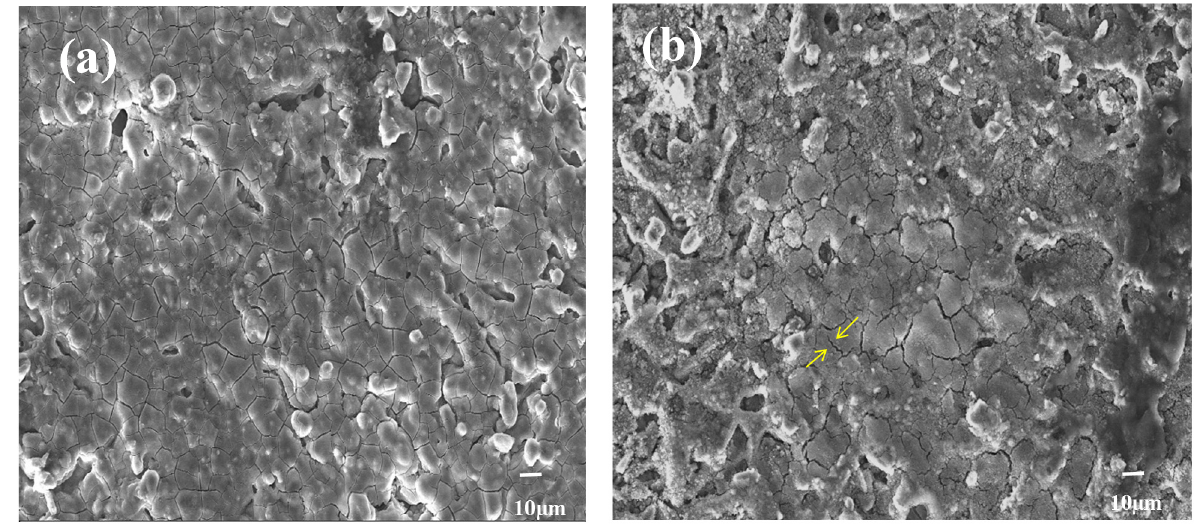
Figure 6. SEM images of corrosion products for Al-20SiC composites after electrochemical test: ( a ) five pulses, ( b ) 15 pulses.